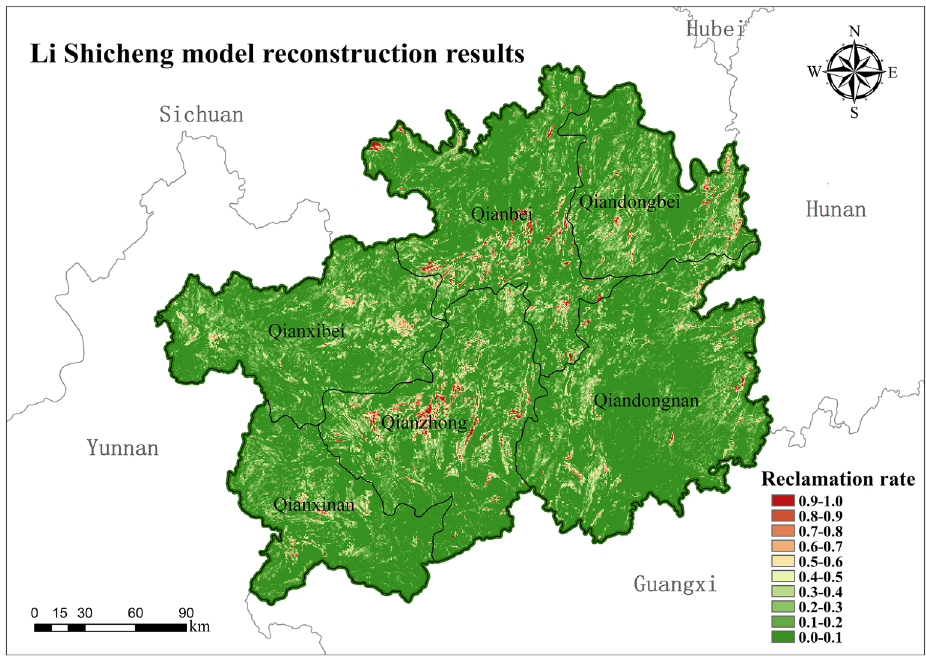
Figure 8. Reconstruction results of the cropland spatial pattern in 1820 by Li Shicheng model (map created using ArcGIS